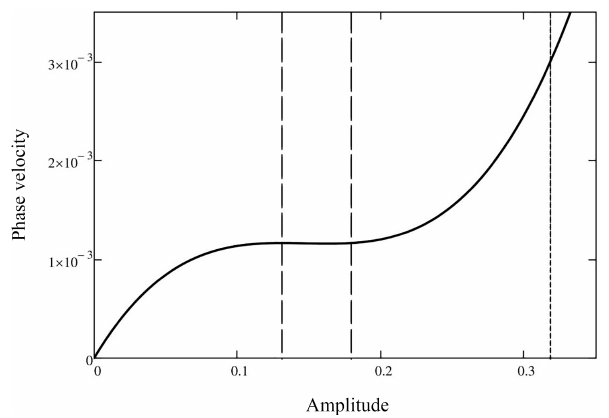
Figure 5. Phase velocity versus wave amplitude. Solid line: c ( 1 ) ( A 0 , dashed lines 0 < A 0 = A 1 and A 0 = A 2 ). Dotted line: A 0 = A ∗ = 1 /π , the critical amplitude above which the model does not work as a vortex core arises inside the wave. A 2 = 0 . 1311; A 1 = 0 . 1793.